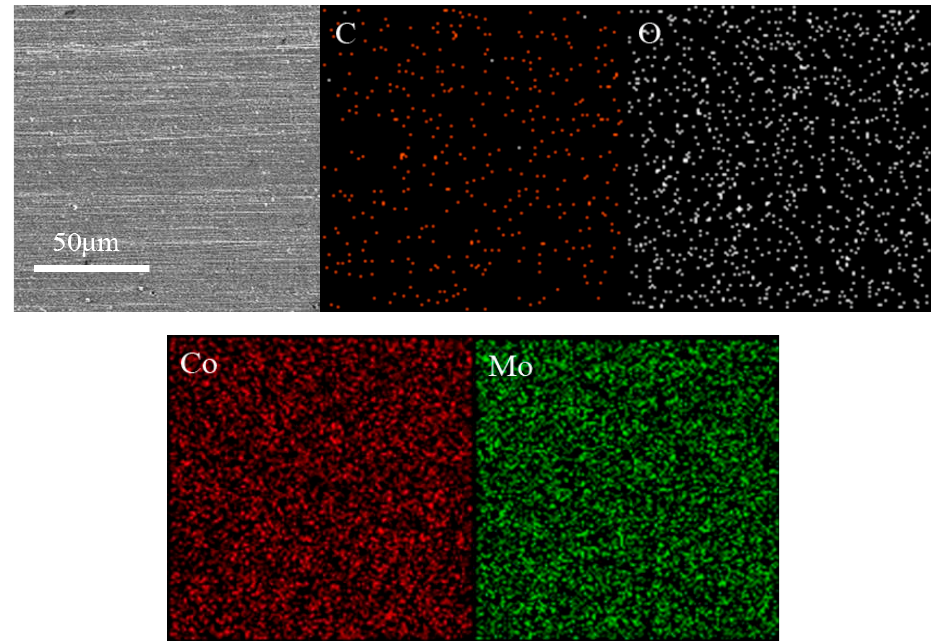
Figure 10. Element distribution on the surface of Co-Mo alloy coating.